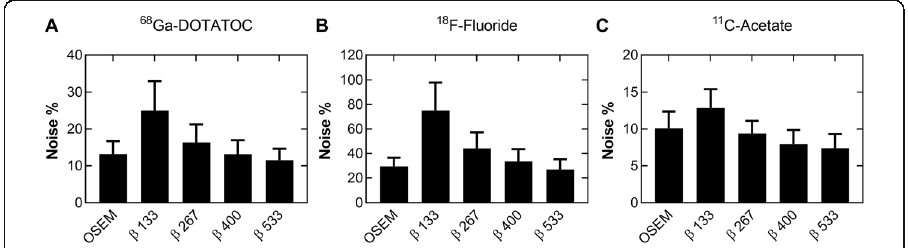
Fig. 3 Noise measured in normal liver tissue for 68 Ga-DOTATOC ( a ), 18 F-fluoride ( b ), and 11 C-acetate ( c ), respectively, using BSREM and OSEM (3 iterations, 16 subsets, 5-mm Gaussian post-processing filter). Both reconstruction methods included TOF and PSF